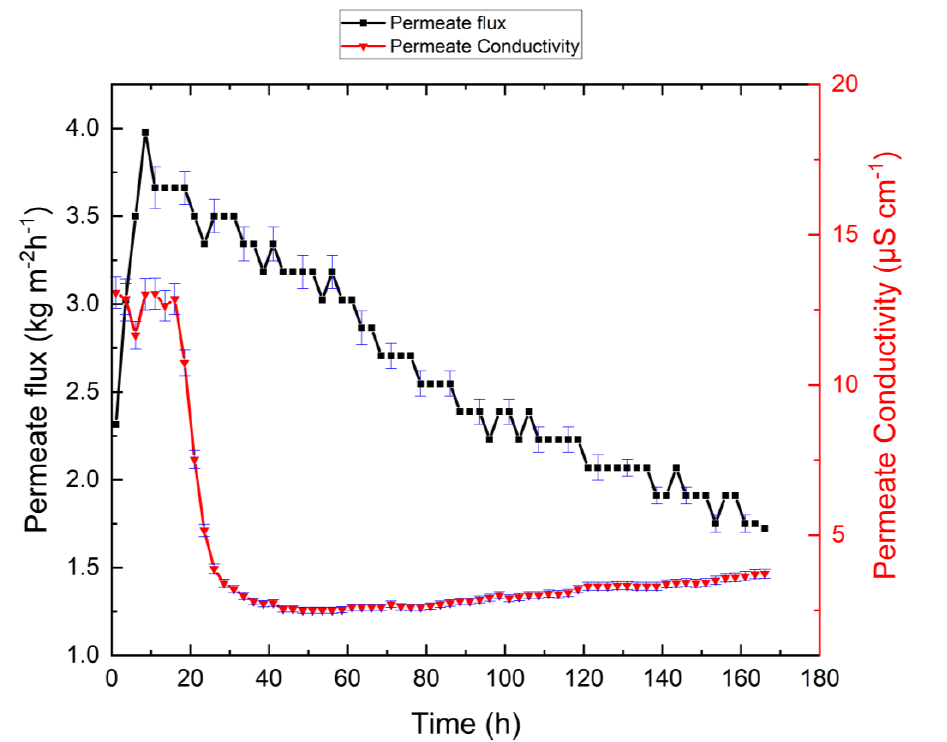
Figure 5. Permeate flux and permeate electrical conductivity as functions of time for the synthetic brine feed system with antiscalant. The antiscalant led to higher initial permeate flux compared to the system without antiscalant. Permeate electrical conductivity remained relatively low.